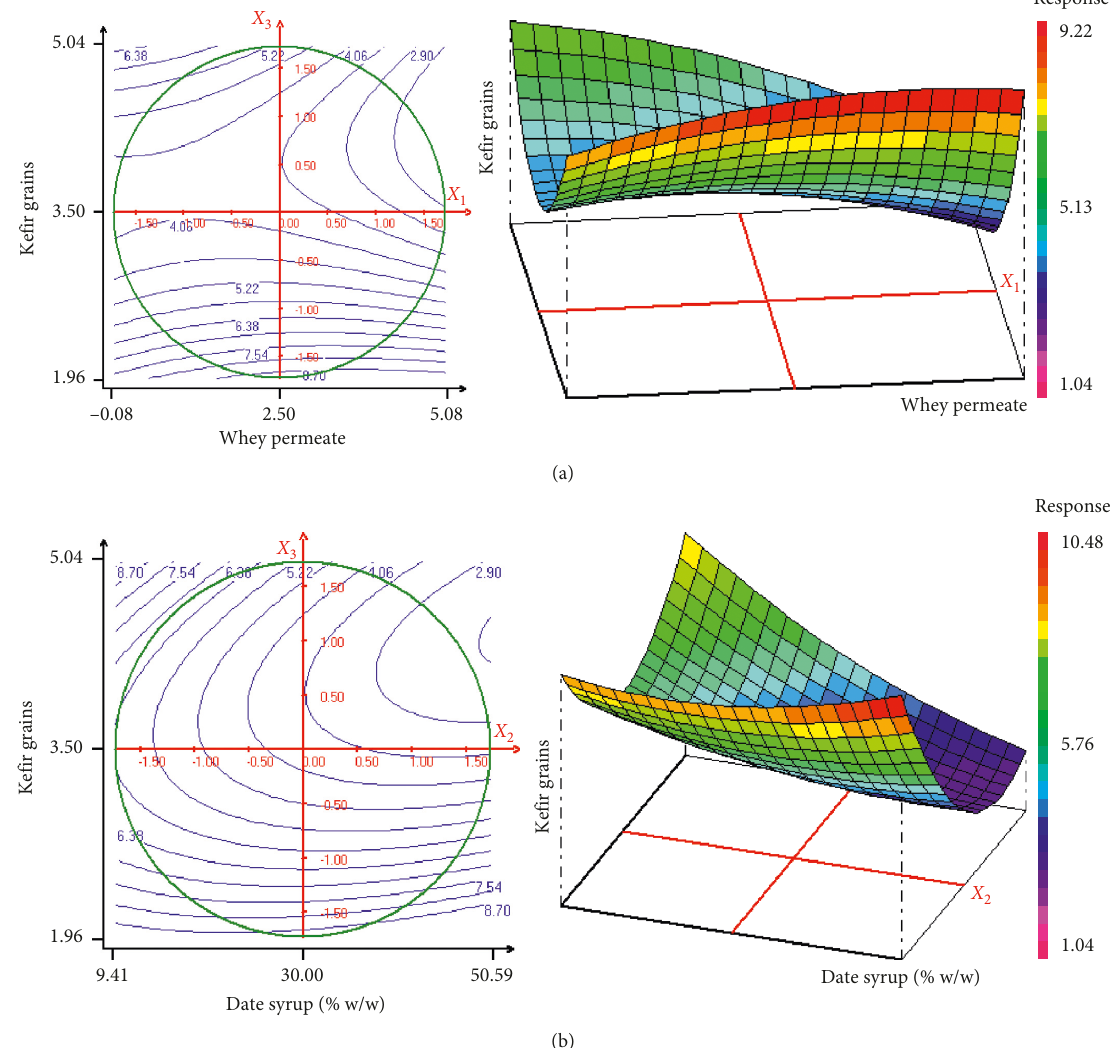
Figure 1: Response surface and contour plots that represent the effect of WP and kefir grains (a) and the effect of kefir grains and date syrup on LAB counts (b) ( X 1 : whey permeate (% w/v); X 2 : date syrup (% w/v); X 3 : kefir grains (%